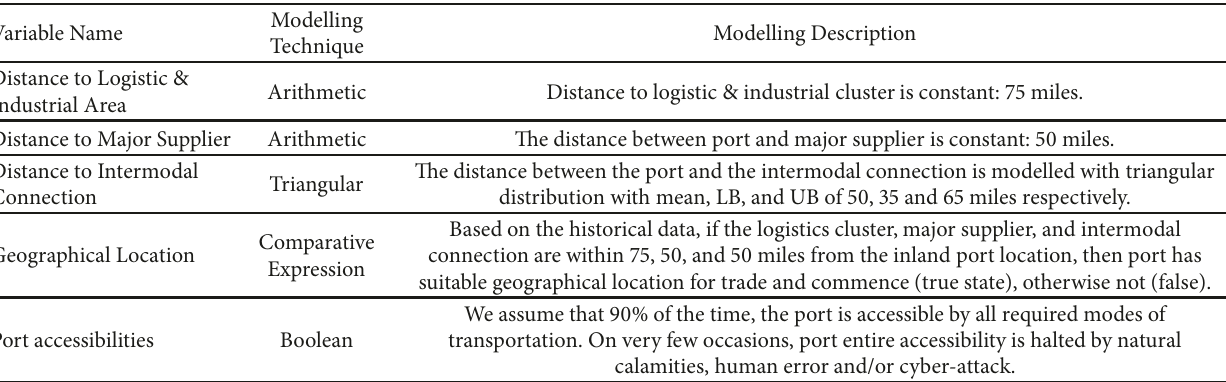
Table 9: NPTs of the variables describing the contributor to geographical location and port